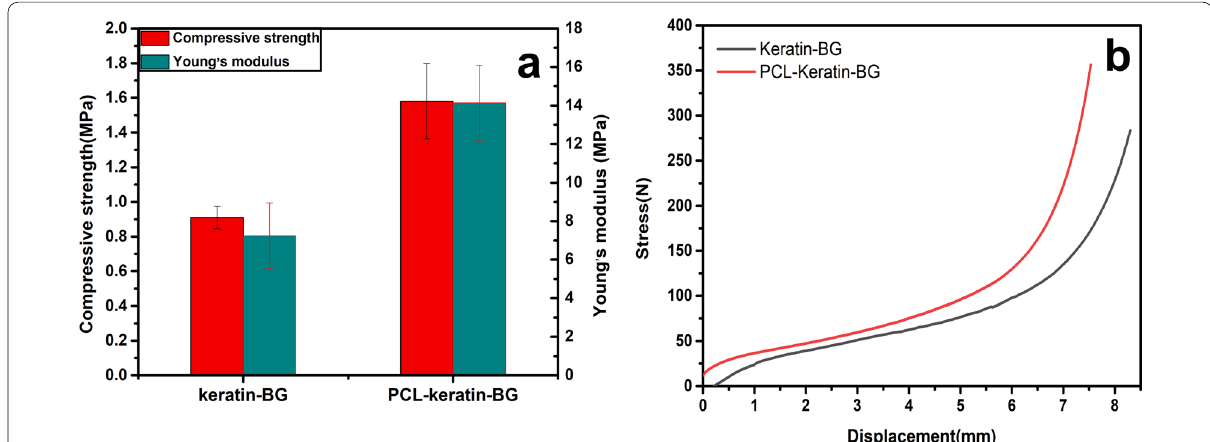
Fig. 6 a Compressive strength, Young’s modulus and b stress-displacement curves of keratin-BG and